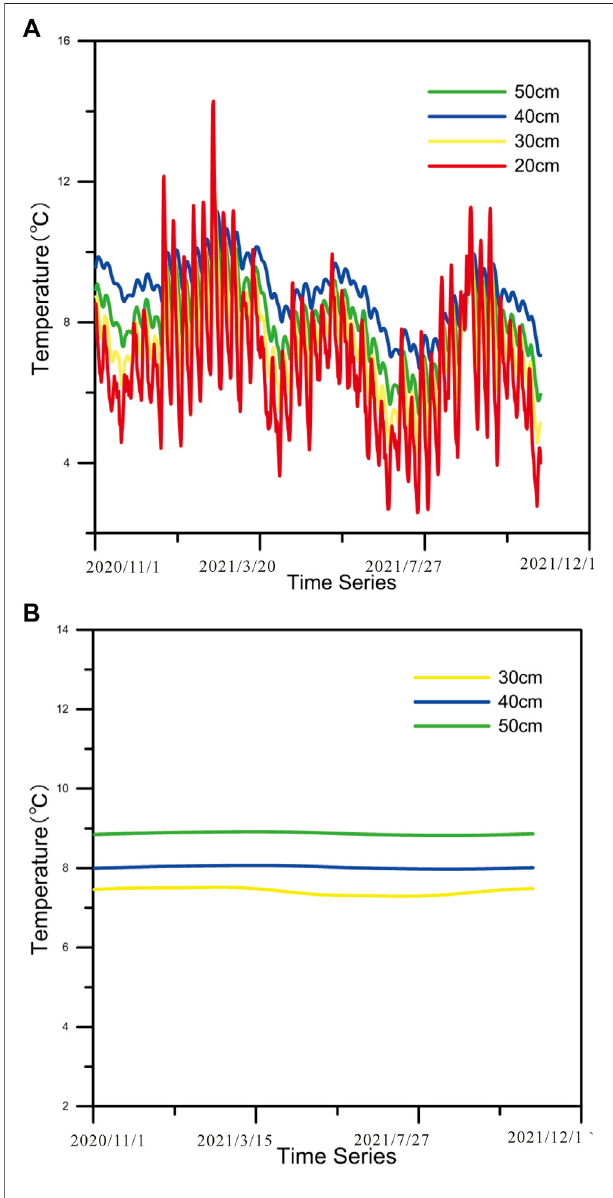
FIGURE 3 | Measured temperature at different soil depths (A) and calculated results after temperature correction (B) .